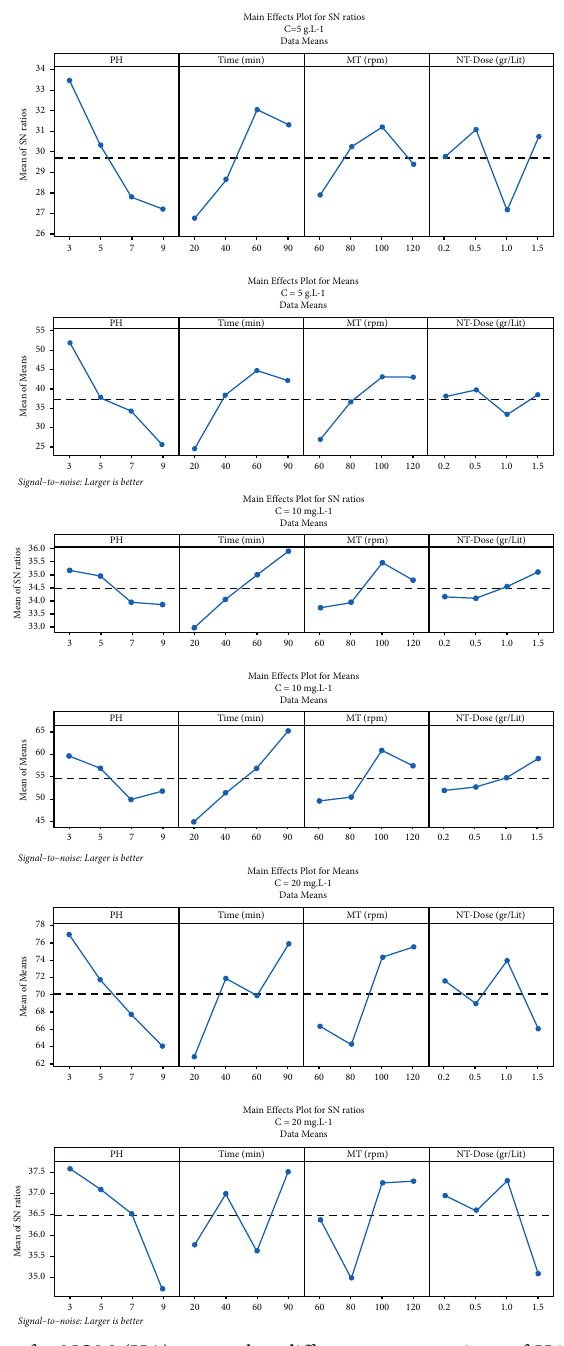
Figure 2: Optimal conditions for NOM (HA) removal at diferent concentrations of HA using the Taguchi